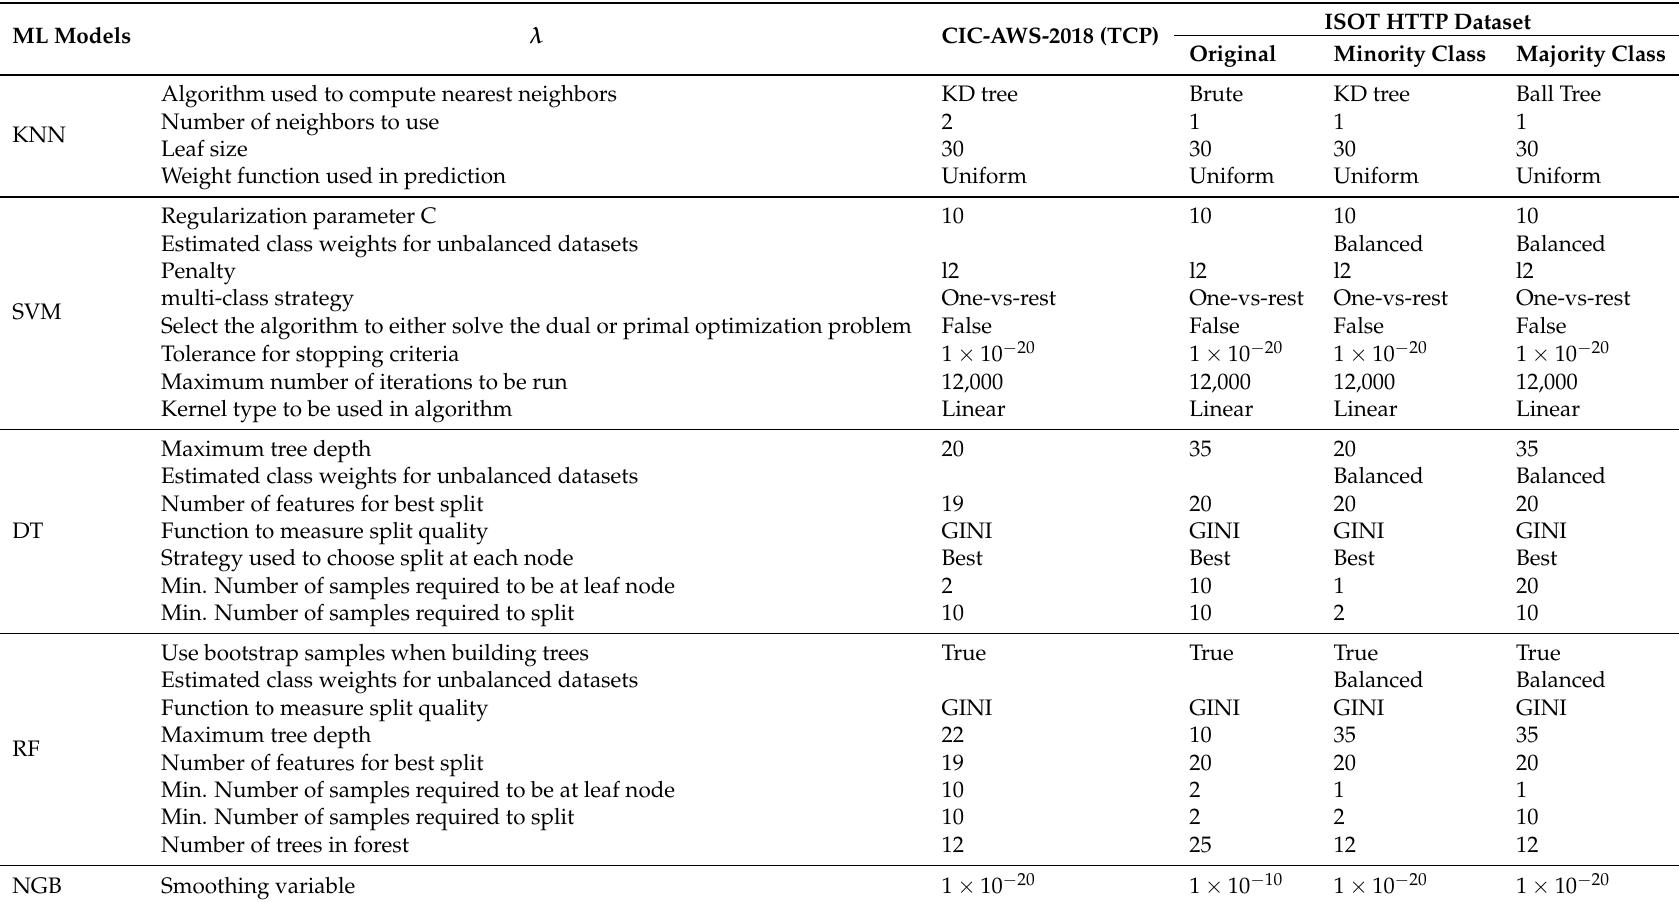
Table 2. ML models + GS-based hyperparameters ( λ